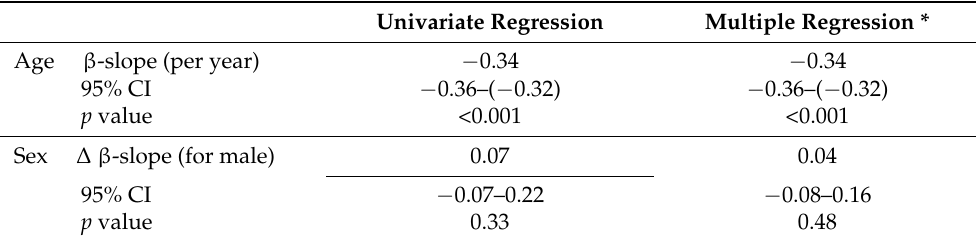
Figure 2. Distribution of SPISE over age. Curved lines and ribbons represent local polynomial regression fitting with 95% confidence intervals. Table 2. Linear regression analysis with SPISE as dependent variable and sex and age as independent variables at baseline.